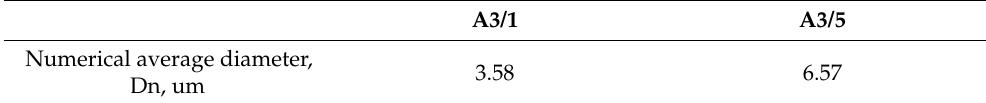
Figure 10. Normal distribution curves of particles diameter. Table 12. Numerical average diameter values of A3/1 and A3/5 blends.